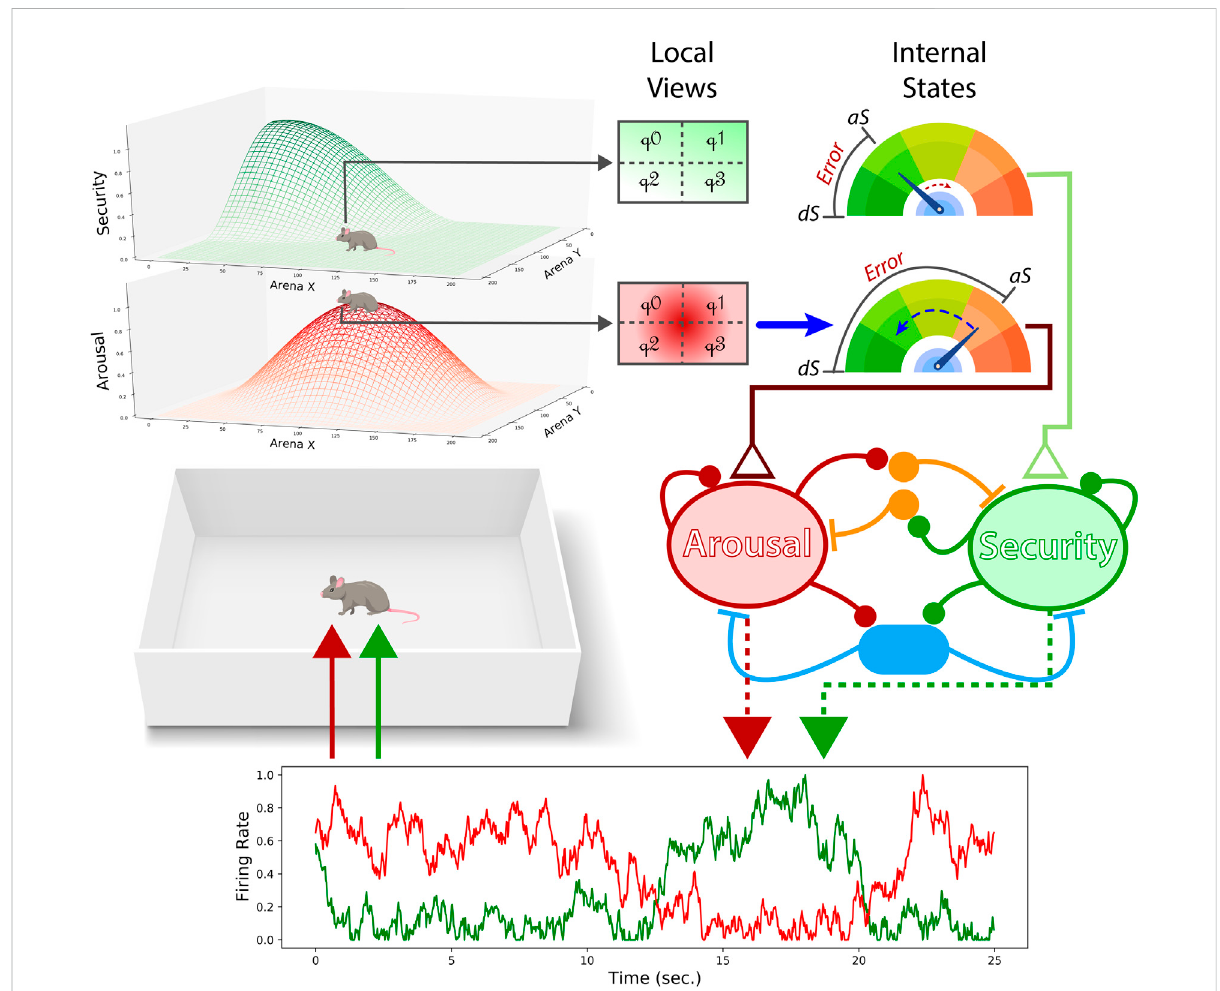
FIGURE 1 Performanceoftheneuralmass allostatic model inan open fi eld. Twogradients represent theareas where thetwointernalneeds, arousal (red) and security (green), can be ful fi lled (top-left). The agent partially observes those gradients through local sensation (top-middle). Local sensation allows the agent to adjust its actions to ascend/descend the gradients and detect when the observer ’ s current position is in the vicinity of the resource area (i.e., the peak of the gradient). If the agent is not close enough to the resource area, the internal state related to that resource keeps declining, as the security actual state (aS) is doing in this fi gure (top-right). In contrast, if the agent occupies the peak of the gradient, the internalstateapproximates thedesiredstate(dS),asshownwitharousal.TheaSsanddSsarecompared,creatingahomeostaticerror(top-right)that willinputtheirrespectiveexcitatorypoolsintheneuralmassmodel(middle-right).Thelevelofcompetitionisde fi nedbytheratioofmutualinhibition (orangeinterneurons)andsharedfeedbackinhibition(blueinterneurons).Finally,the fi ringrateofeachexcitatorypopulationprovidestheagentwith the corresponding drives given its internal